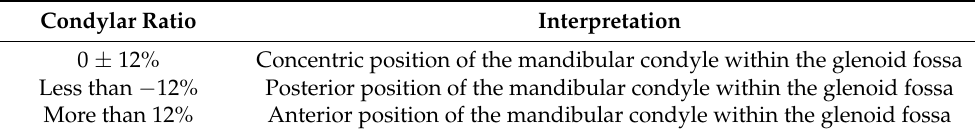
Table 3. Interpretation of the Pullinger and Hollender’s formula on the basis of the literature [20]. Condylar Ratio Interpretation 0 ± 12% Concentric position of the mandibular condyle within the glenoid fossa Less than − 12% Posterior position of the mandibular condyle within the glenoid fossa More than 12% Anterior position of the mandibular condyle within the glenoid